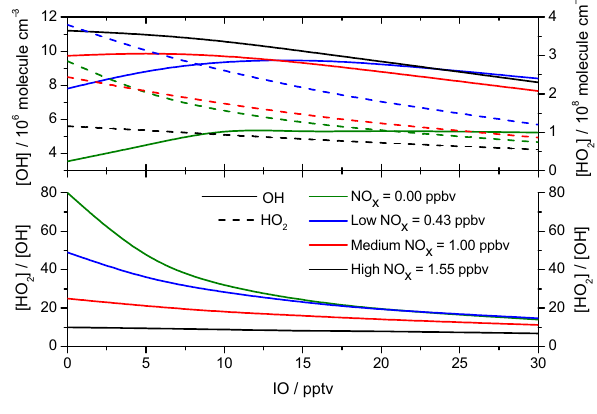
Fig. 17. [IO] (black) and particle number (2.5nm <d < 10nm, blue) Fig. 18. The effect of IO on OH and HO 2 concentrations and Fig.17. [IO](black)andparticlenumber(2.5nm < d < 10nm,blue)on7thand8thSeptember. IOdisplaysabroaderprofilethanparticle Fig. 18. The effect of IO on OH and HO 2 concentrations and the HO 2 /OH ratio at noon at different fixed NO x concentrations (low NO x numberonthe7th. Thisisnotobservedtothesameextentonthe8th,seetextforfurtherdetails. on 7 and 8 September. IO displays a broader profile than particle scenario, NO x = 0.43 ppbv, medium NO x scenario, NO x = 1 ppbv, high NO x scenario, NO x = 1.55 ppbv). The plot shows how HO x the HO 2 /OH ratio at noon at different fixed NO x concentra- concentrationsvarywithincreasingIO.Thesolidlinerepresents[OH]andthedashedlinerepresents[HO 2 ]. Thebottomplotrepresentsthe number on the 7th. This is not observed to the same extent on the tions (low NO x scenario, NO x =0.43ppbv, medium NO x scenario, HO 2 /OHratio. 8th, see text for further details. NO x =1ppbv, high NO x scenario, NO x =1.55ppbv). The plot shows how HO x concentrations vary with increasing IO. The solid line represents [OH] and the dashed line represents [HO 2 ]. The bottom plot represents the HO 2 /OH